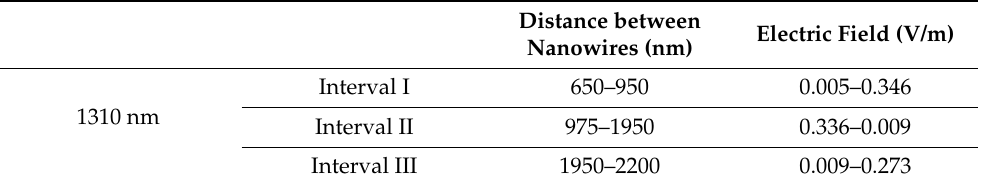
Table 3. Most significant intervals of the scattered field for λ = 1310 nm.